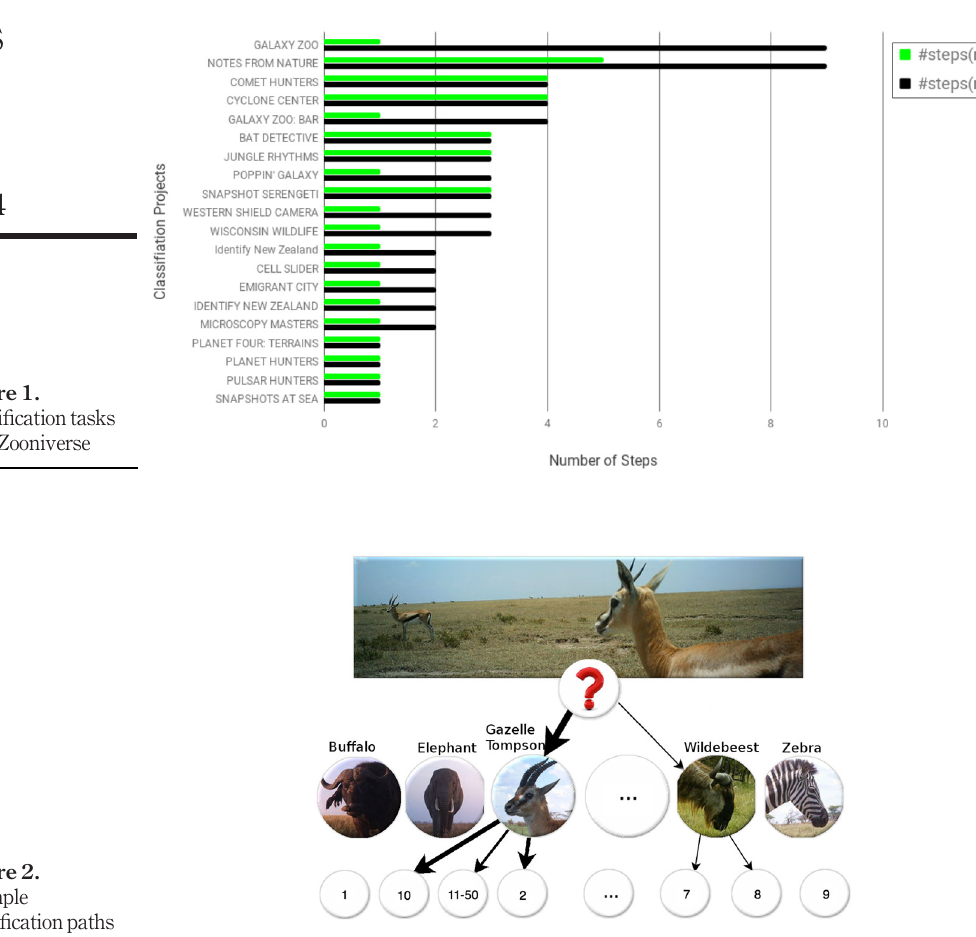
Figure 2. Example classi fi cation paths collected from 20 workers for a given photo